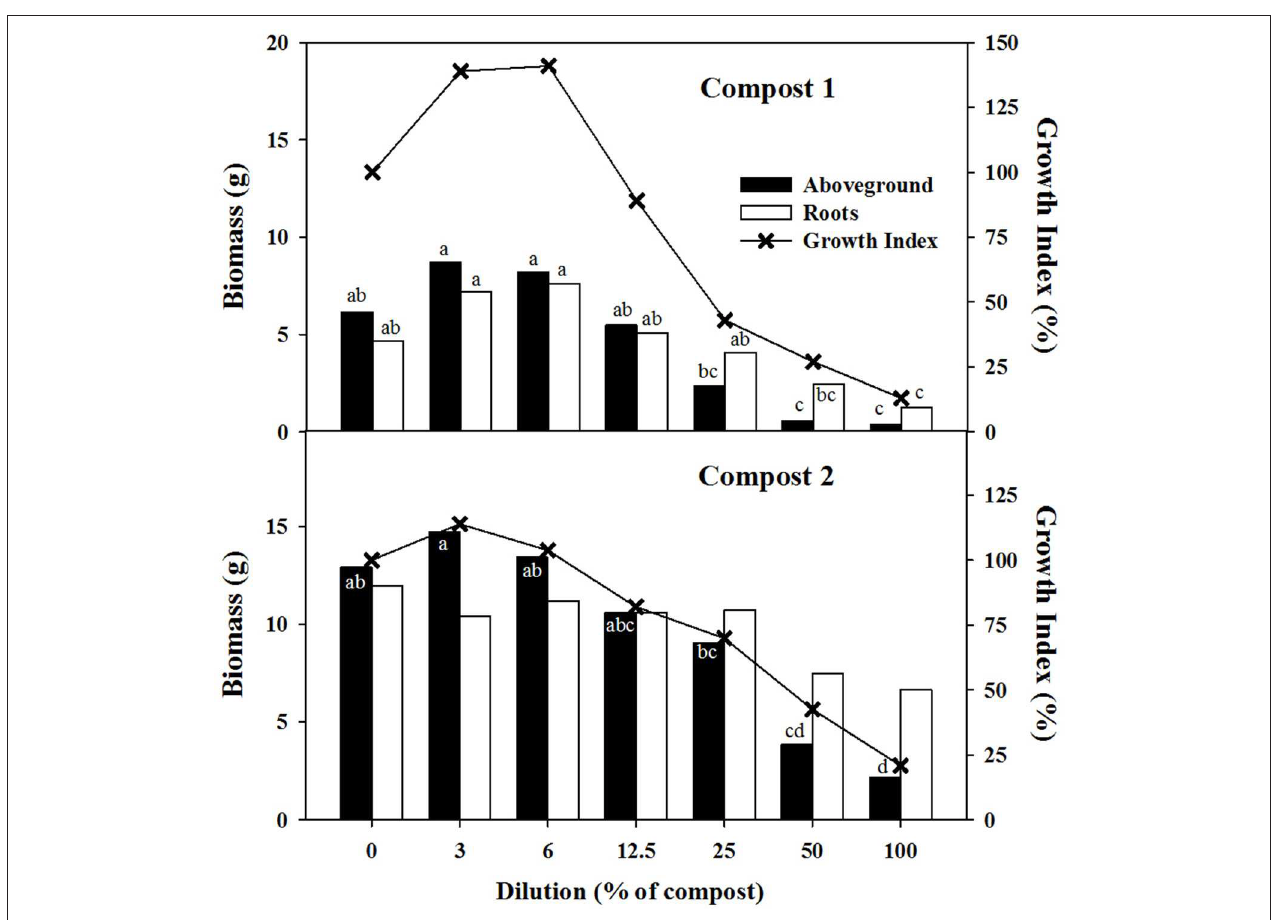
FIGURE 2 | Fresh weight of the aboveground and roots of Zea mays (g per treatment) and the Growth Index, at different proportions of compost, in the toxicity test. Bars (aboveground or roots) with the same letter are not significantly different according to Tukey’s test at p < 0.05.